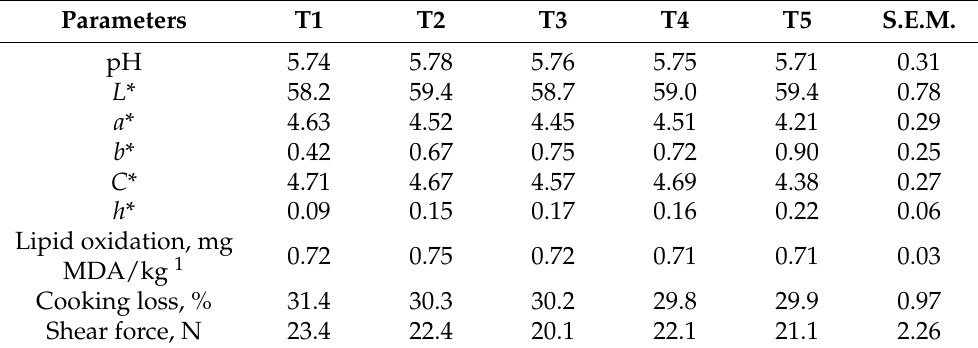
Table 5. Predicted least square means of breast meat quality parameters of broiler chickens at 42 days of age fed different levels of Black Soldier Fly larvae